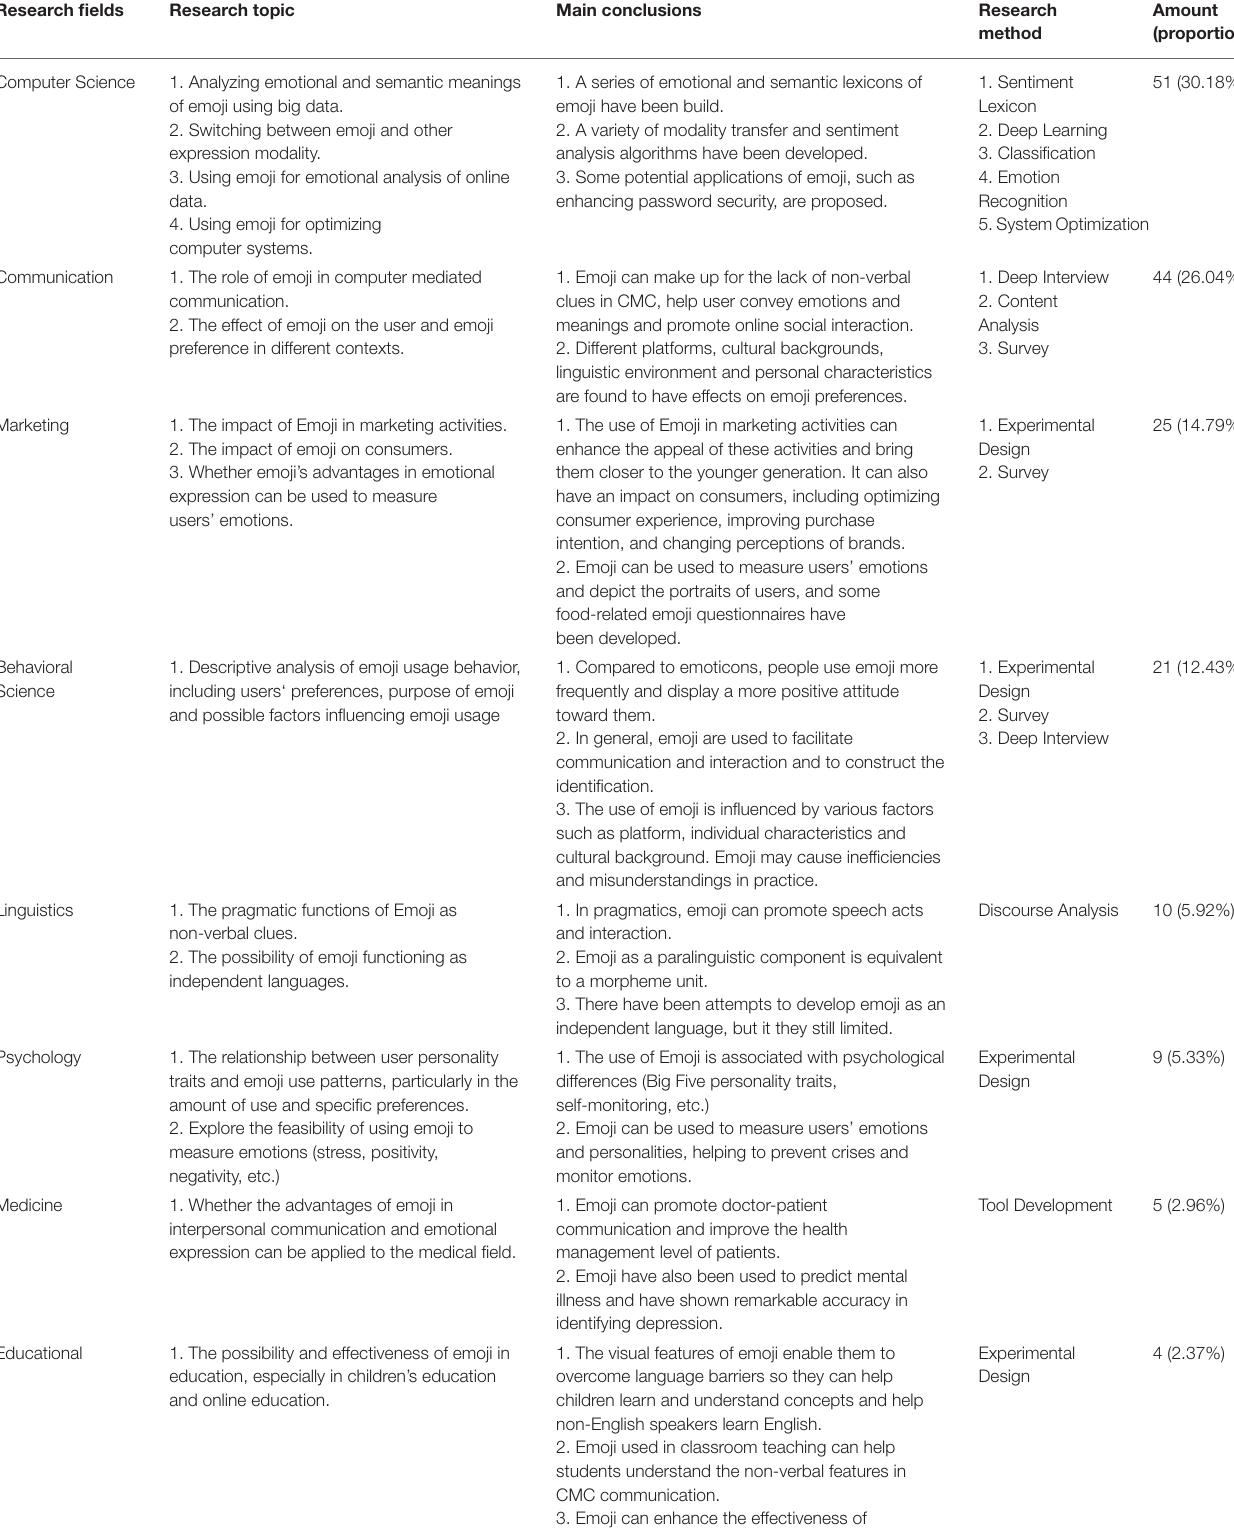
TABLE 2 | Main research fields, research topics, main conclusions, research methods, and number of publications for